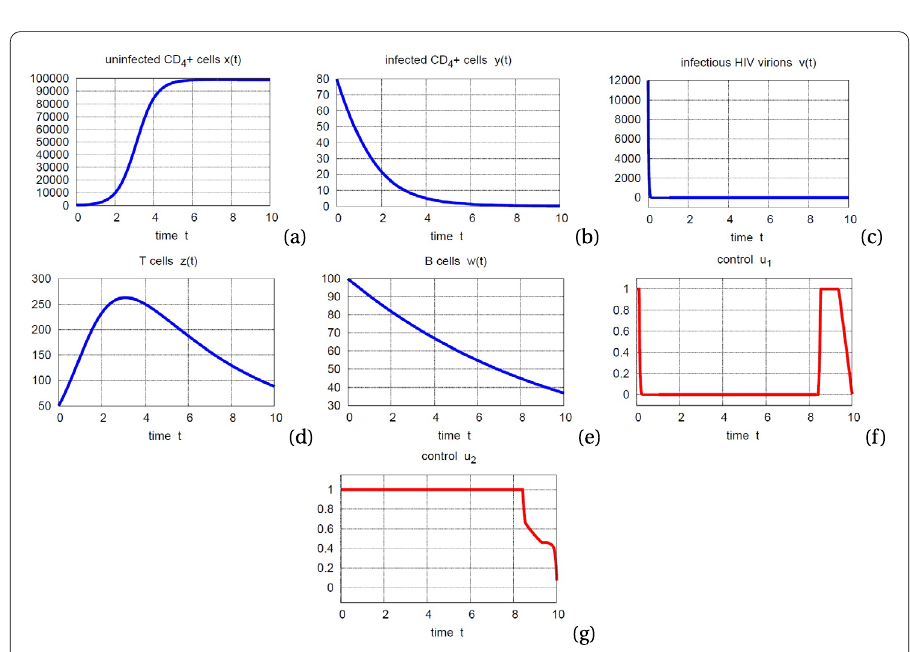
Figure 2 ( a ) Saturation level of uninfected CD + 4 T-cells with optimal control for Column 4 of Table 2 ( b ) Level of infected CD + 4 T-cells with optimal control for Column 4 of Table 2 ( c ) level of viral load with optimal control for Column 4 of Table 2 ( d ) level of T-cells with optimal control for Column 4 of Table 2 ( e ) level of B-cells with optimal control for Column 4 of Table 2 ( f ) Behavior of optimal control, u ∗ 1 as protease inhibitor for Column 4 of Table 2 ( g ) Behavior of optimal control, u ∗ 2 as reverse transcriptase inhibitor for Column 4 of Table